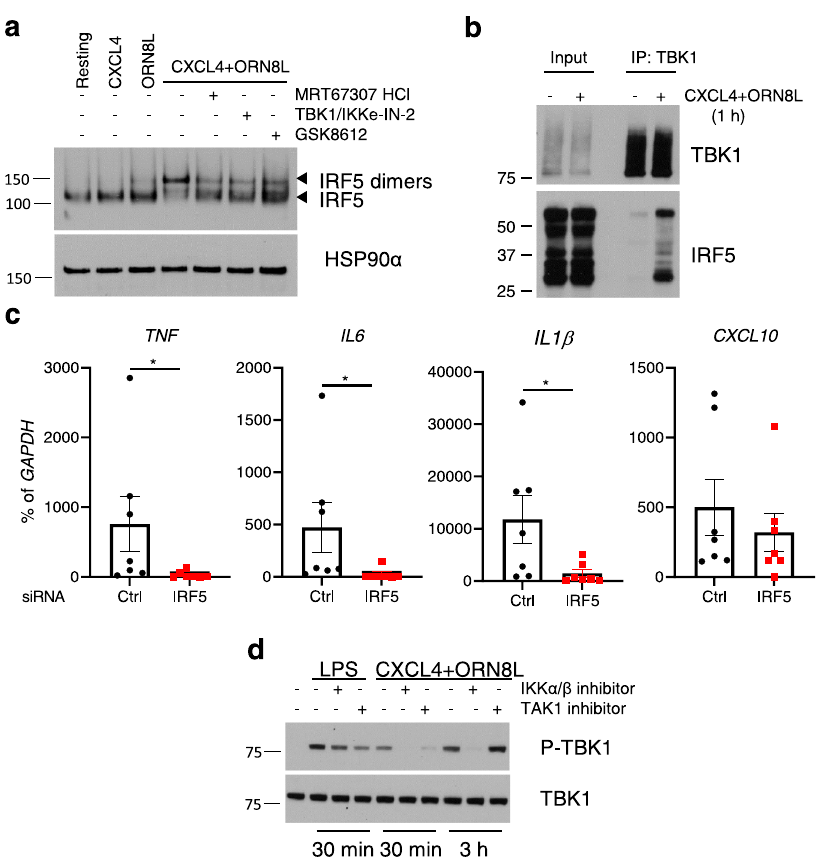
Fig. 6 CXCL4 and TLR8 costimulation activates TBK1-IRF5 and in fl ammatory gene expression. a Immunoblot of IRF5 using whole-cell lysates run on nondenaturing gels. HSP90 α serves as loading control. b Immunoblot of whole-cell lysates immunoprecipitated with TBK1 antibodies. c qPCR analysis of indicated mRNAs normalized relative to GAPDH mRNA in monocytes nucleofected with control or IRF5-speci fi c siRNAs ( n = 7 independent experiments). d Immunoblots of phospho-TBK1 and total TBK1 with whole-cell lysates after LPS or (CXCL4 + ORN8L) stimulation for 30 min or 3 h in the presence or absence of IKK α / β inhibitor (BMS-345541, 10 µ M) or TAK1 inhibitor (Takinib, 10 µ M). Data ( a , b , d ) are representative of three experiments and depicted as mean ± SEM ( c ). * p ≤ 0.05 by Wilcoxon signed-rank test, two-tailed ( c ). Source data are provided as a Source data fi